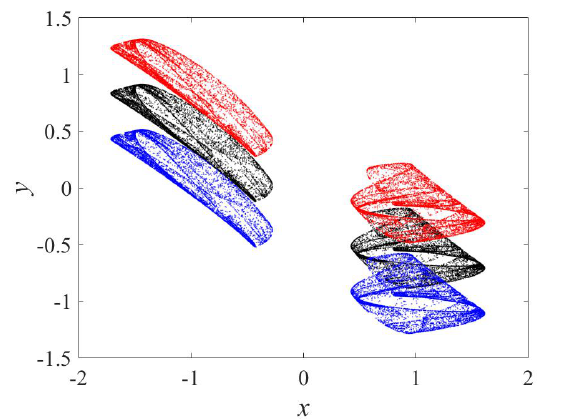
Figure 6. Iterative plots for different k : k = 0 (black), k = − 0.4 (red), k = 0.4 (blue).